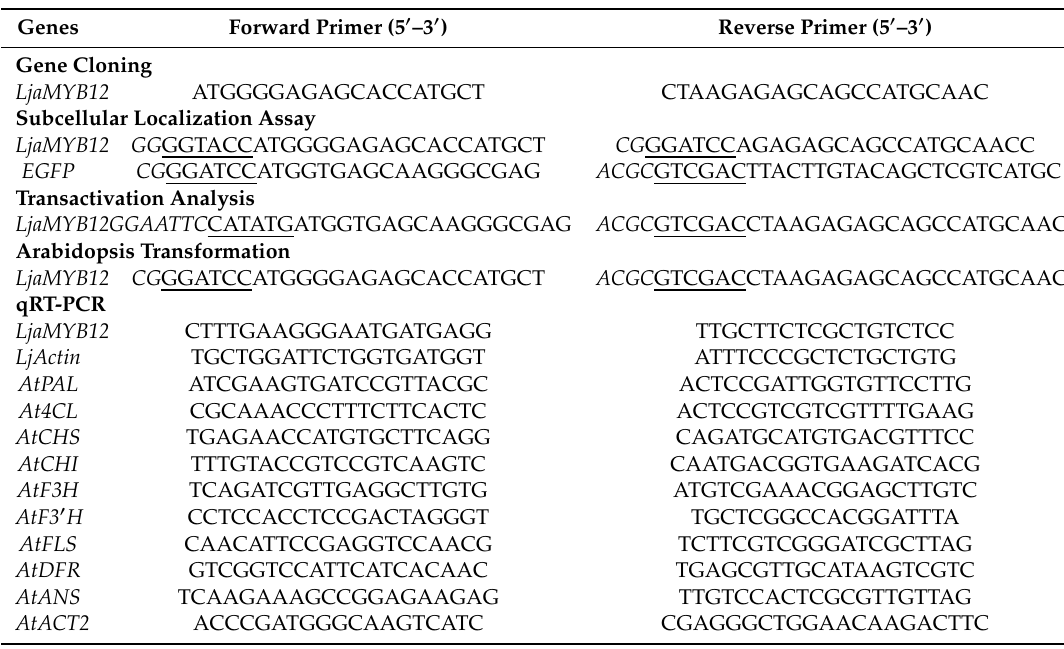
Table 1. Primer sequences used in this